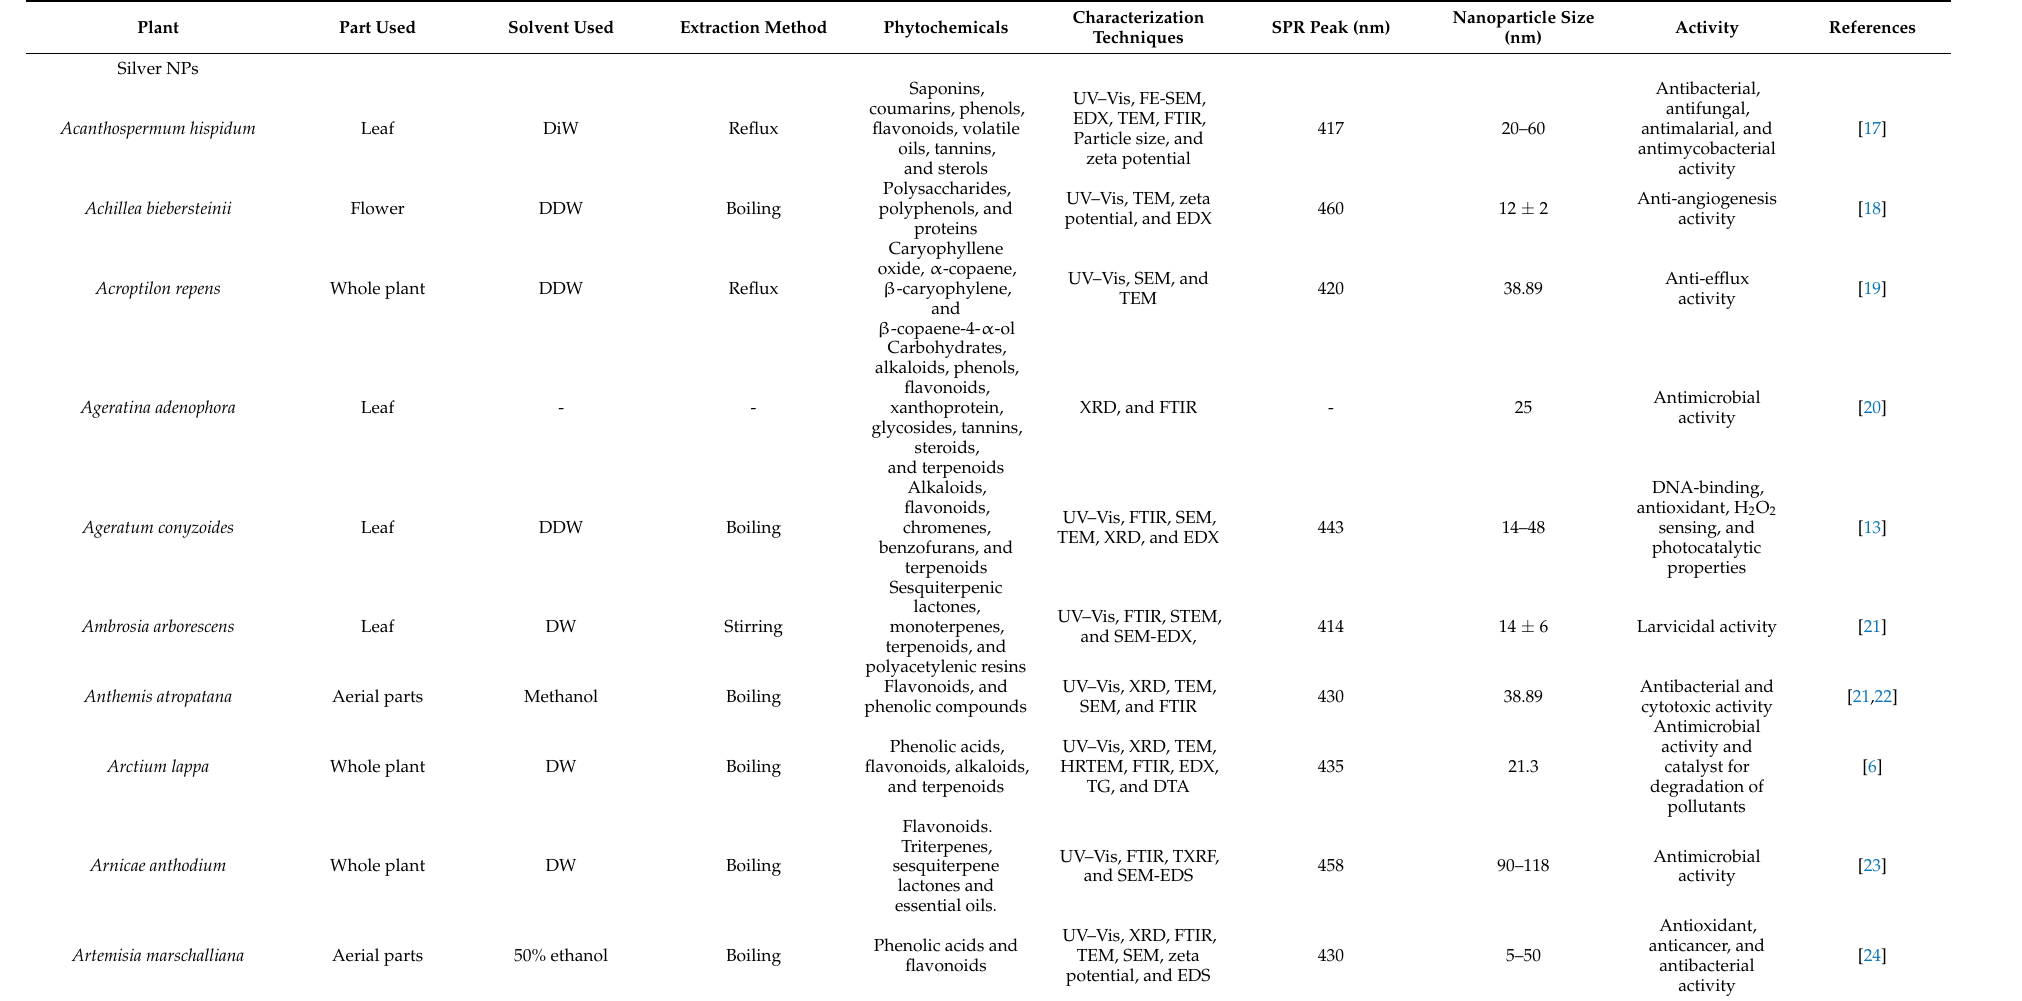
Table 1. Studies carried out to synthesize metal nanoparticles from the Asteraceae family and their biological